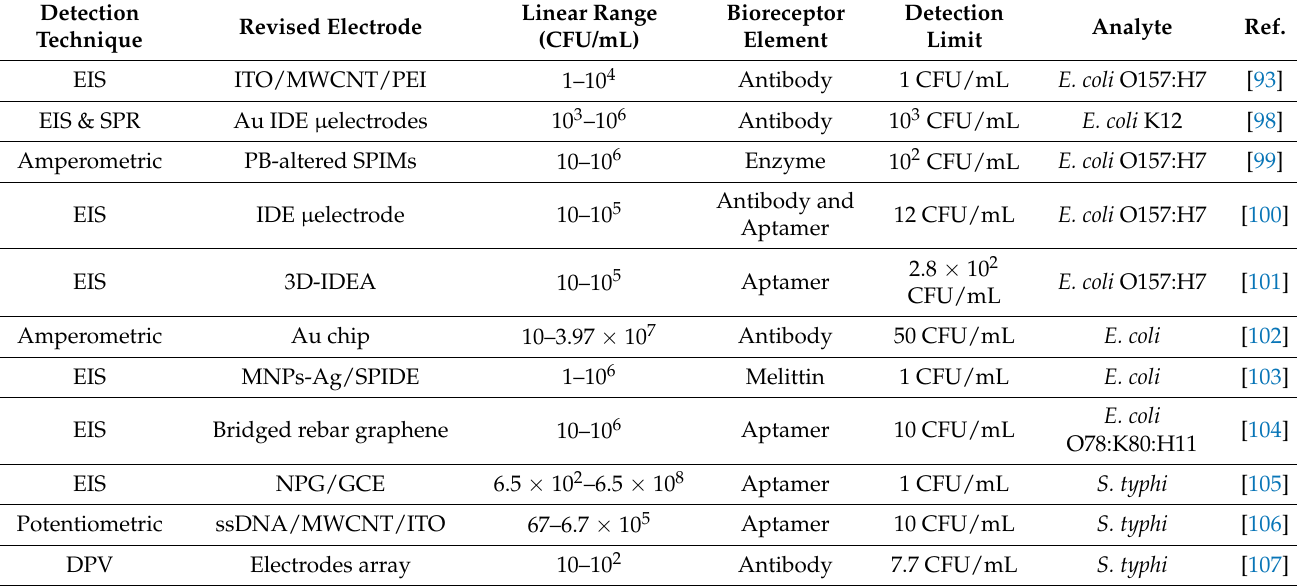
Table 2. Summary of electrochemical biosensors for various foodborne pathogens.